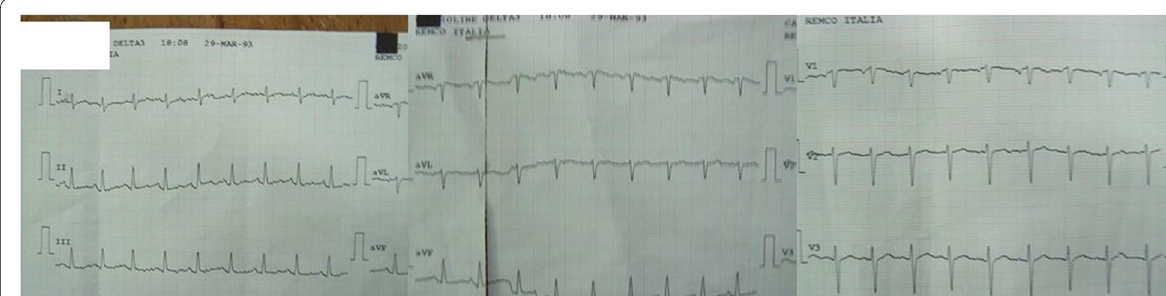
Fig. 3 ECG in case 1 with sinus tachycardia and normal voltage